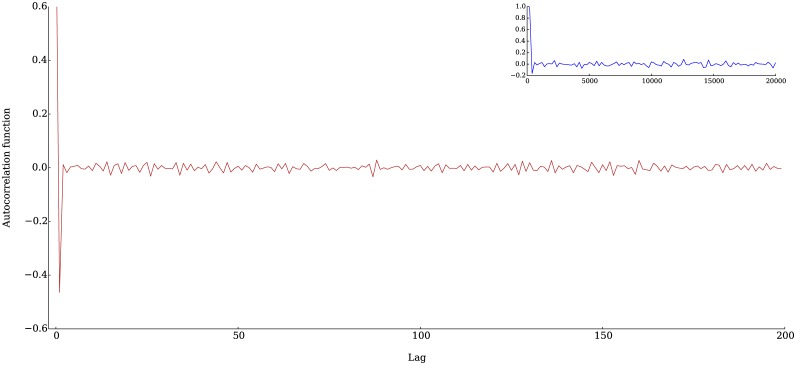
Auto-correlation functions of returns.There are essentially no correlations for any value of the lag, except for a negative correlation that lasts for a few steps at the beginning. This phenomenon is also observed in real returns series and has been called bid-ask bounce [2]. The main figure corresponds to the autocorrelation function of the returns calculated every time step and the inset figure to the returns calculated every 50 steps.